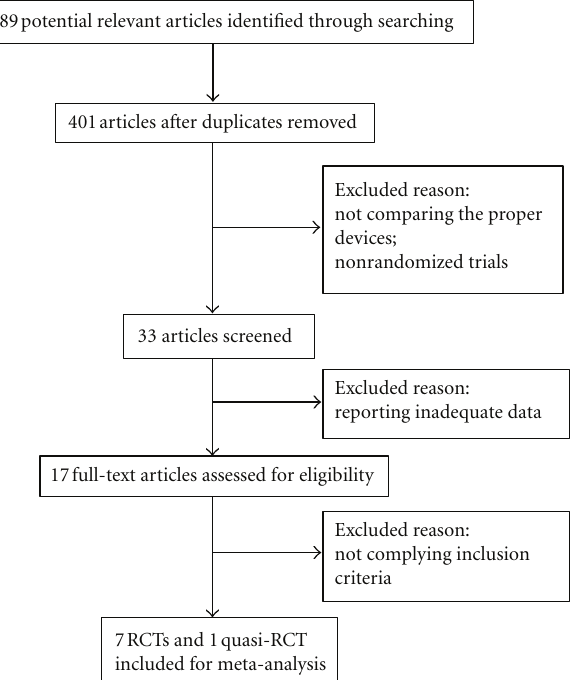
Figure 1: Flow diagram demonstrated methods for identification of studies and reasons for exclusion.